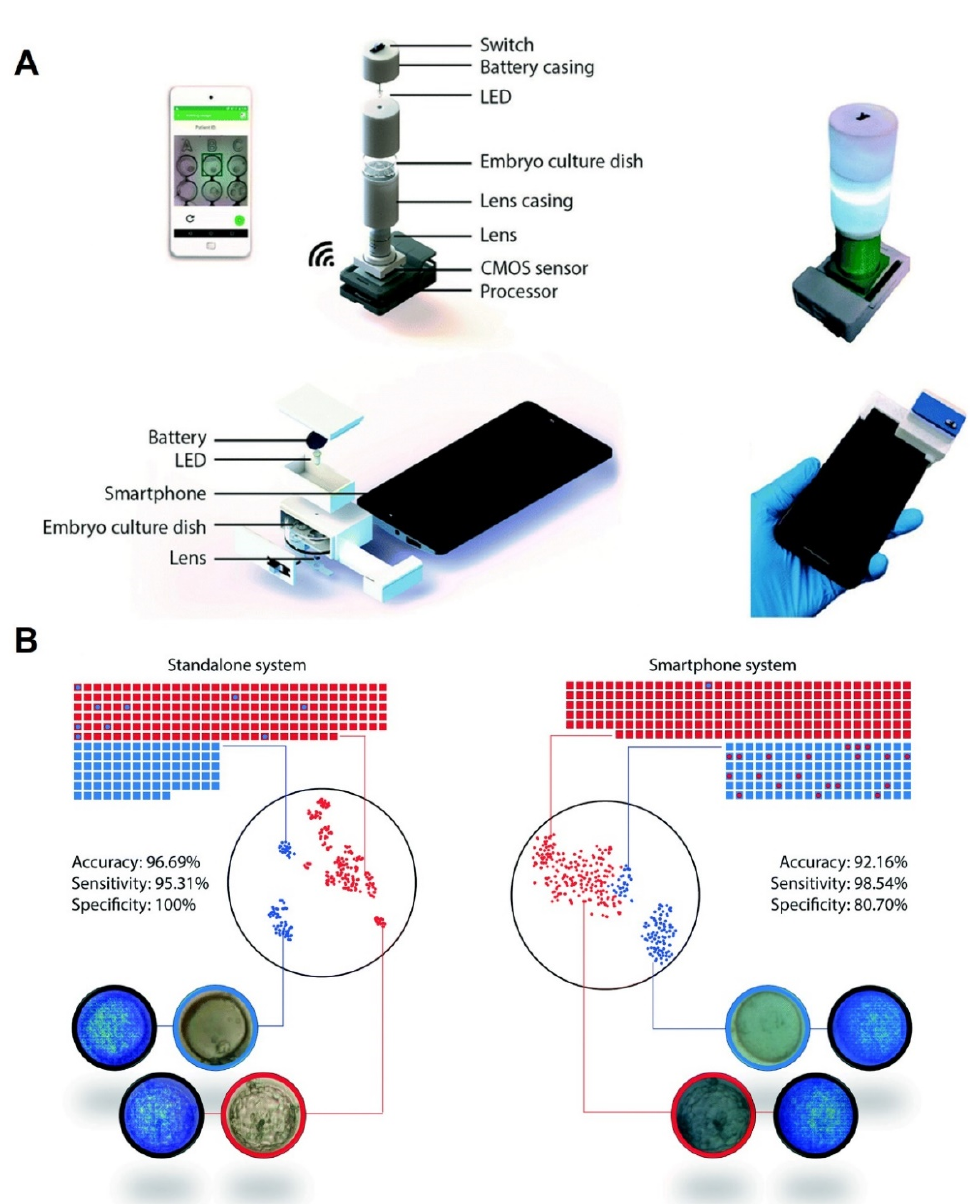
Figure 4. DL-based portable imaging system for embryo assessment and results of the system with pictures taken from stand-alone and cell phone imaging techniques also including a t-SNE and saliency visual analytics. ( A -top) Autonomous (wireless) imaging device for embryo assessment and the specific parts. ( A -bottom) Diagram of an embryo imaging device based on a cellphone and its major elements. ( B -left) The efficiency of the system in assessing imaged embryos using an autonomous device ( n = 272). ( B -right) The efficiency of the device when testing cellphone-imaged embryos ( n = 319). The rectangles depict true marks, and the circles are the classification of the method within them. Blue dots represent non-blastocysts, and red dots show blastocysts. Scatter plots produced by t-SNE are provided to help illustrate the distinction of blastocyst and non-blastocyst embryo pictures taken by ( B -left) the autonomous module and ( B -right) the cellphone. Reproduced with permission from